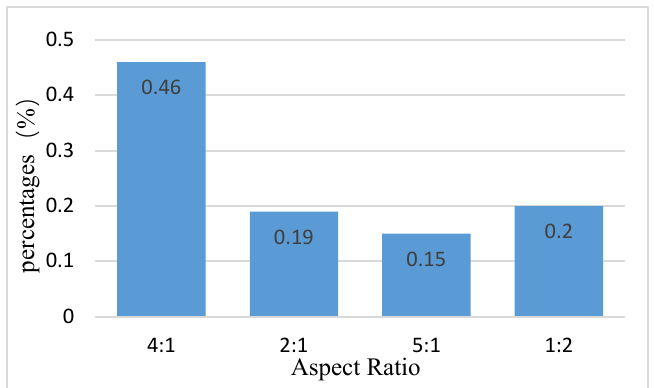
Figure 14. The graph of crack aspect ratio.